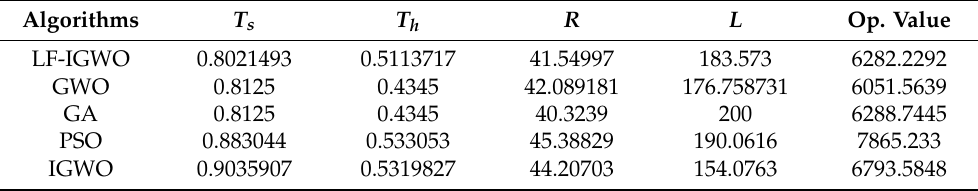
Table 11. Comparison of cost values obtained from LF-IGWO with other techniques.